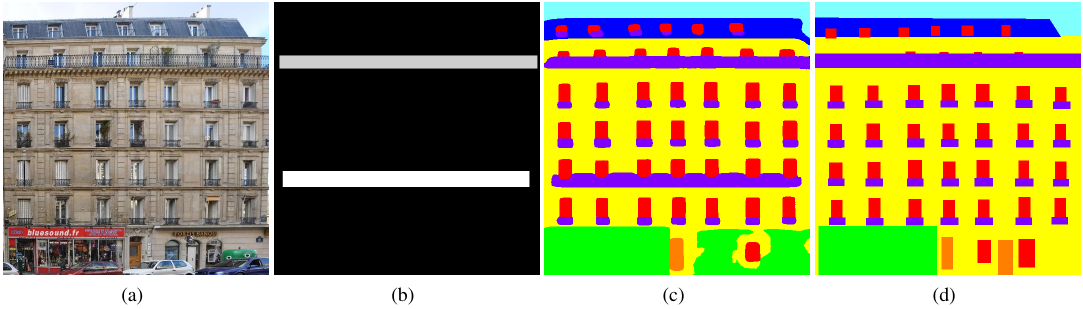
Figure 6. This segmentation has a low accuracy since the object detector proposes with high confidence a long (running) balcony in the middle of the facade. Although this long balcony does not exist, the Structured Random Forest (SRF) “trusts” the Region Proposal Network(RPN) output and the SRF produces a wrongly labeled image. Column (a) input image, (b) RPN output for long balcony (c) result from SRF, and (d) ground truth. Object